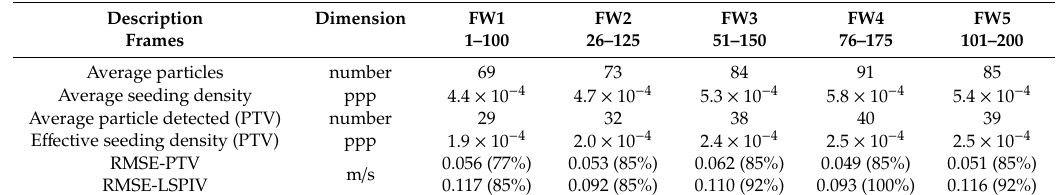
Table 4. Average seeding characteristics of frame sequences with root mean square error (RMSE)